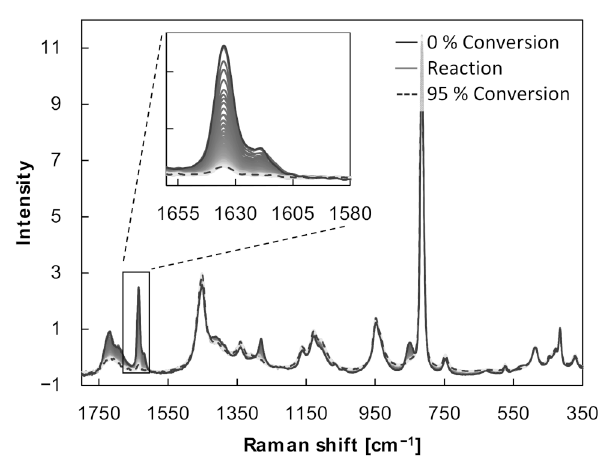
Figure 2. Raman spectra of the reaction of 150 g/L acrylic acid in isopropyl alcohol at 75 ◦ C every 32 s up to a conversion of 95%, determined by the integration of the highlighted band at 1635 cm − 1 corresponding to the C=C stretching